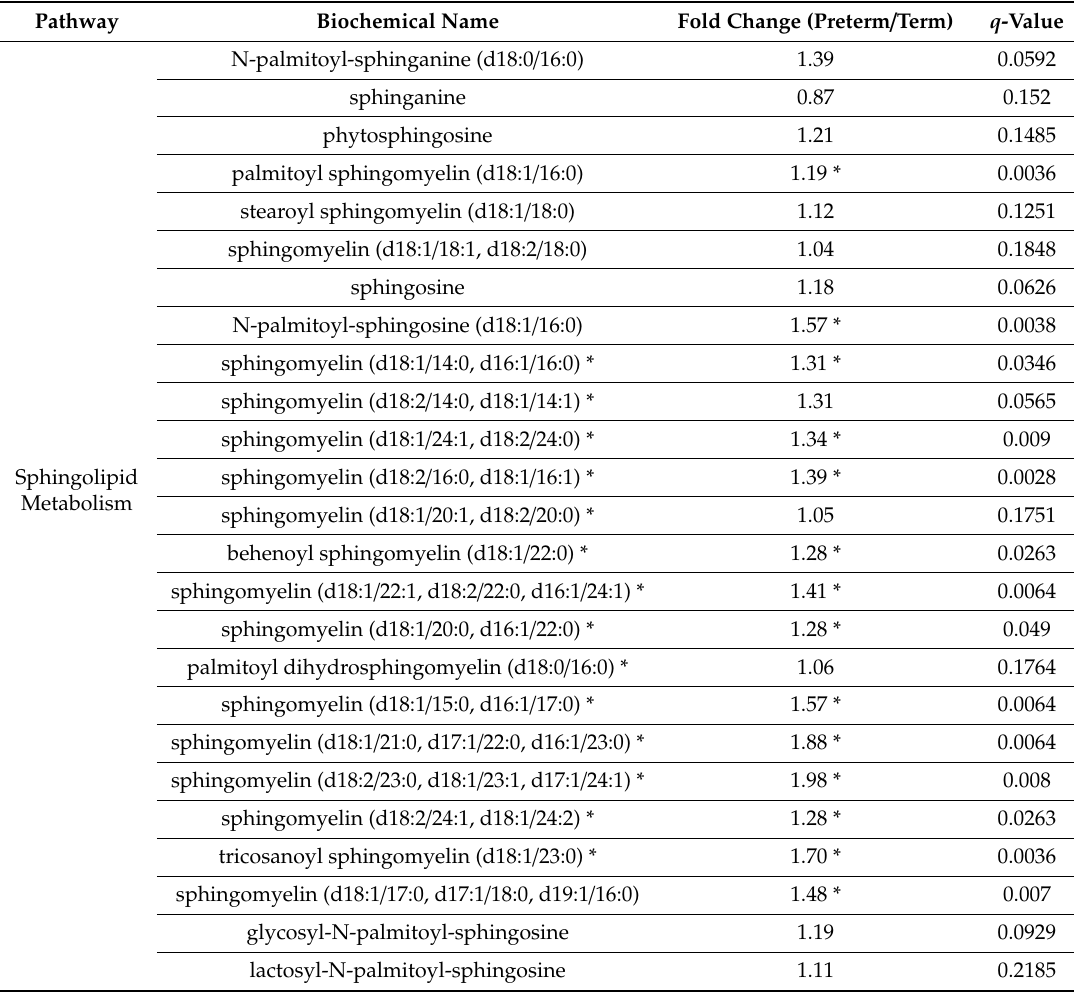
Table 5. Fold change in sphingolipids in